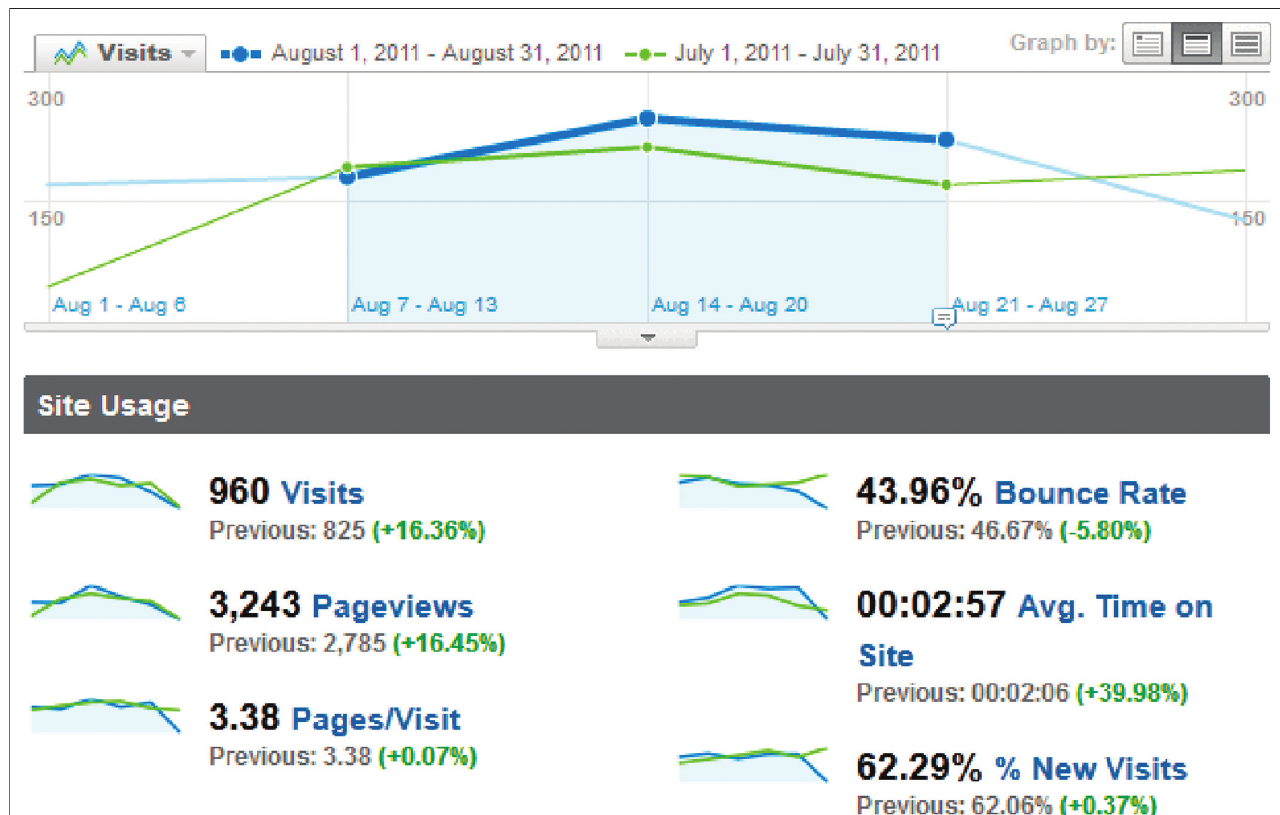
FIGURE 3: Effect of product descriptions, content and metadata improvement on website